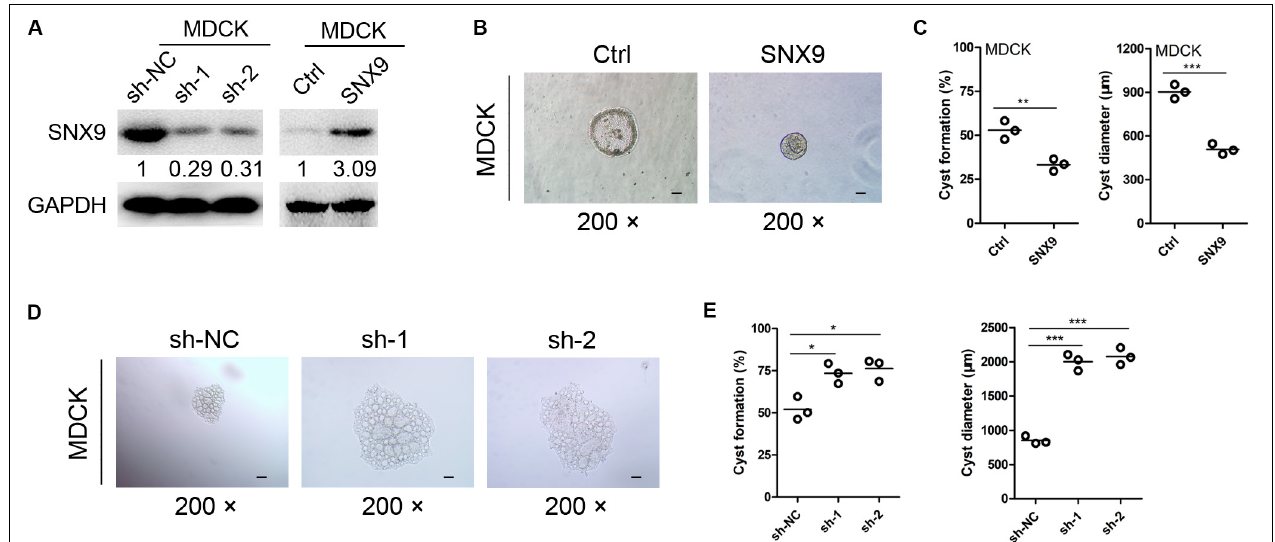
FIGURE 3 | SNX9 inhibits renal cyst formation and enlargement. (A) The SNX9 overexpression and silencing effects were examined by Western blot analysis. (B) SNX9-overexpressing and control MDCK cells were subjected to three-dimensional cultures, to establish a renal cyst formation model. Representative cysts are shown. Scale bars, 200 µ m. (C) The percentage of cyst formation and the cyst diameters of the indicated cells are shown. Data are presented with scatterplots and mean values; n = 3. **Indicates P < 0.01; ***indicates P < 0.001 by Student’s t -test. (D) SNX9-depleted and control MDCK cells were subjected to three-dimensional cultures, to establish a renal cyst formation model. Representative cysts are shown. Scale bars, 200 µ m. (E) The percentage of cyst formation and cyst diameters of the indicated cells are shown. Data are presented with scatterplots and mean values; n = 3. *Indicates P < 0.05; ***indicates P < 0.001 by Student’s t -test.